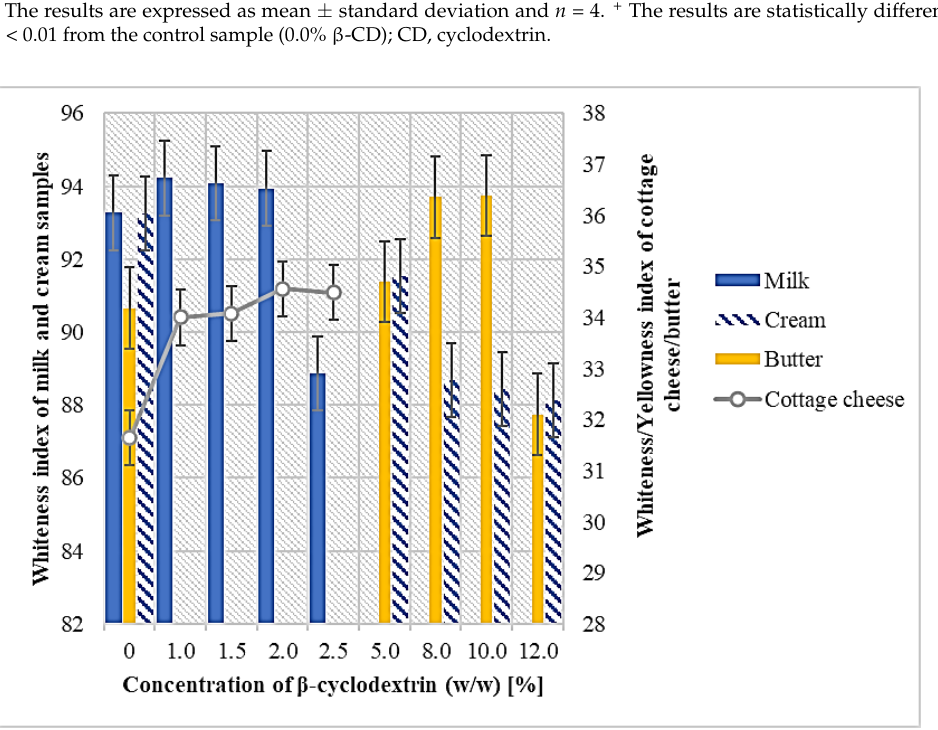
Figure 2. The effect of the concentration of β -cyclodextrin on the whiteness or yellowness index of milk products.